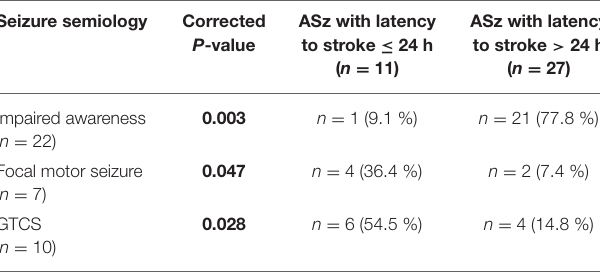
TABLE 4 | Seizure semiology in patients with acute symptomatic seizures (ASz) in relation to time of stroke. Seizure